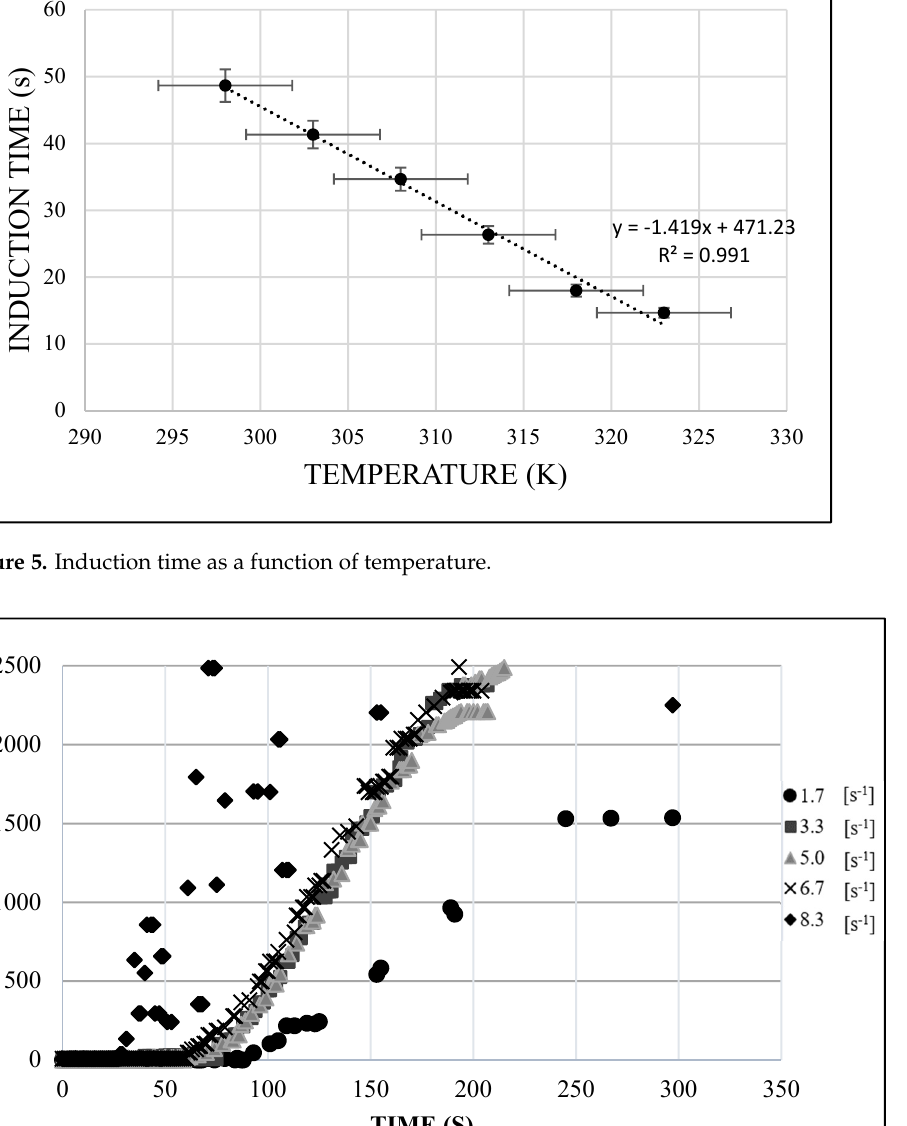
Figure 6. Influence of rotational speed on induction time: • 1.67 (s − 1 ); ■ 3.33 (s − 1 ); ▲ 5.00 (s − 1 ); × 6.67 (s − 1 ); ♦ 8.33 (s − 1 ).